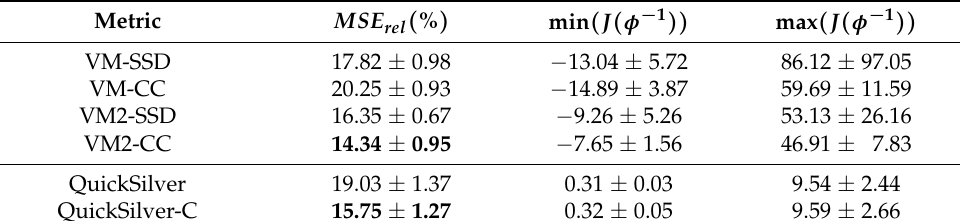
Table 3. NIREP16. Quantitative results of the deep-learning methods. Mean and standard deviation of the relative image similarity error expressed in % ( MSE rel ), and the Jacobian determinant extrema associated with the transformation φ − 1 . The best MSE rel results for each method are highlighted in bold face.